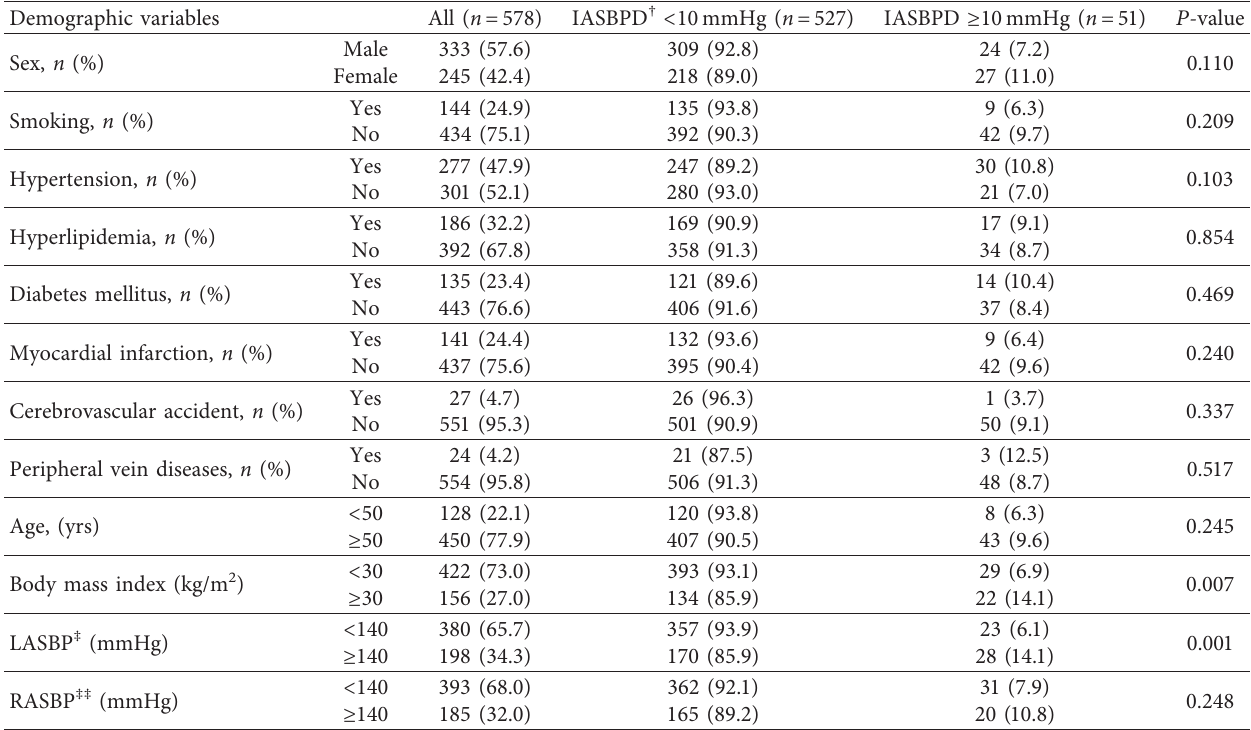
Table 1: Frequency distribution of the demographic variables in terms of IASBPD of less and more than 10 mmHg. Demographic variables